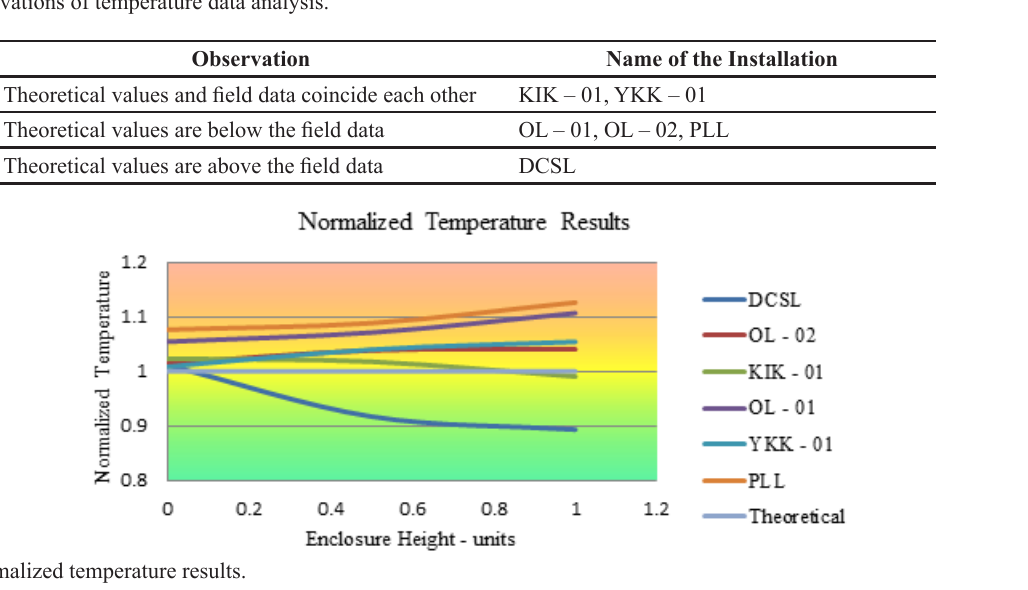
Table 3: Observations of temperature data analysis.